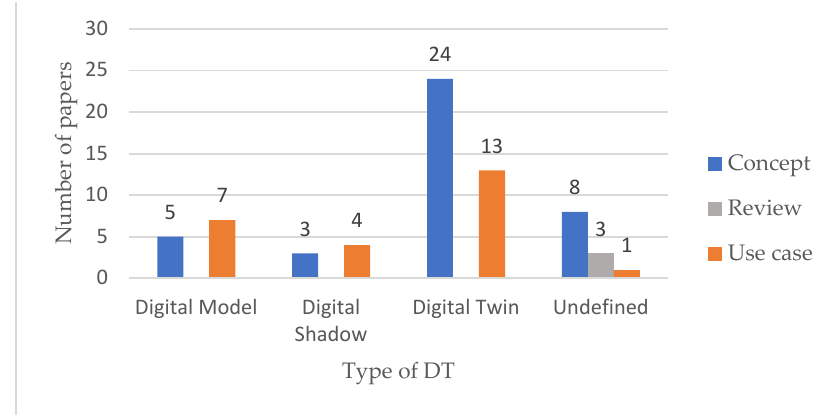
Figure 14. Type of paper for each type of DT.